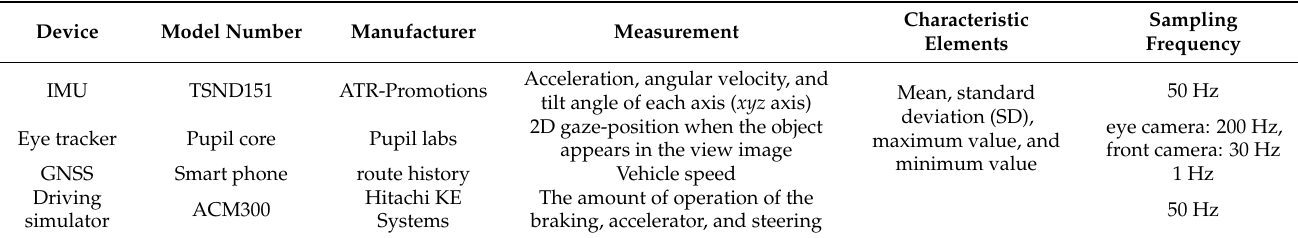
Table 1. The specifications of the measuring